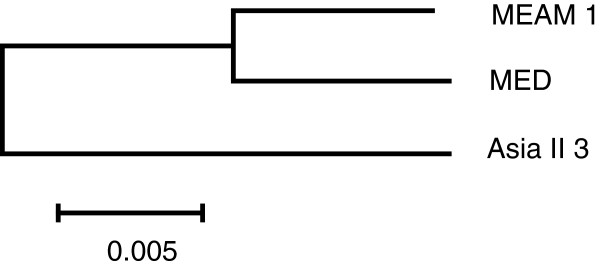
Phylogeny of Asia II 3, MEAM1 and MED. Aligned fragments were extracted for phylogenetic analysis using MEGA 5 and the phylogenetic tree was constructed by the neighbor-joining method.